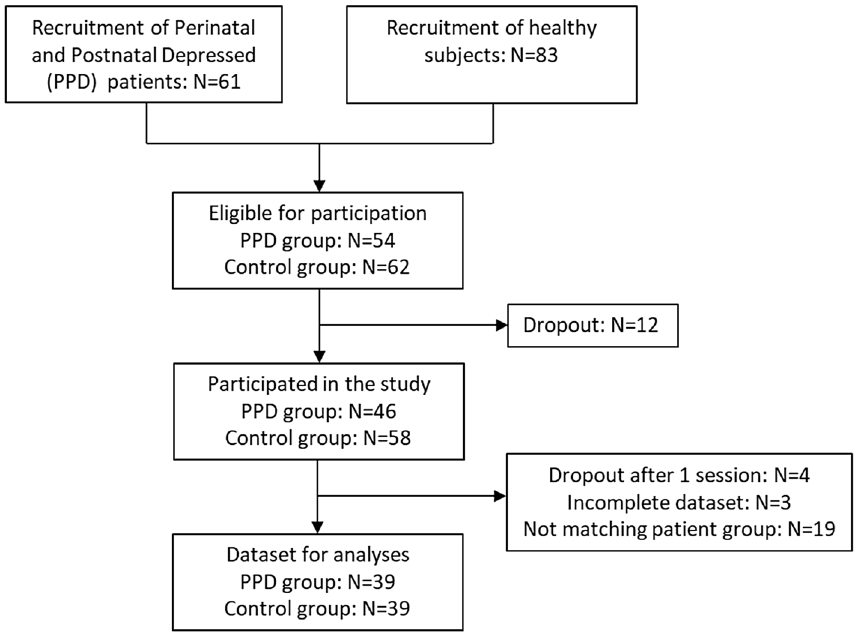
Figure 1. Patient flow